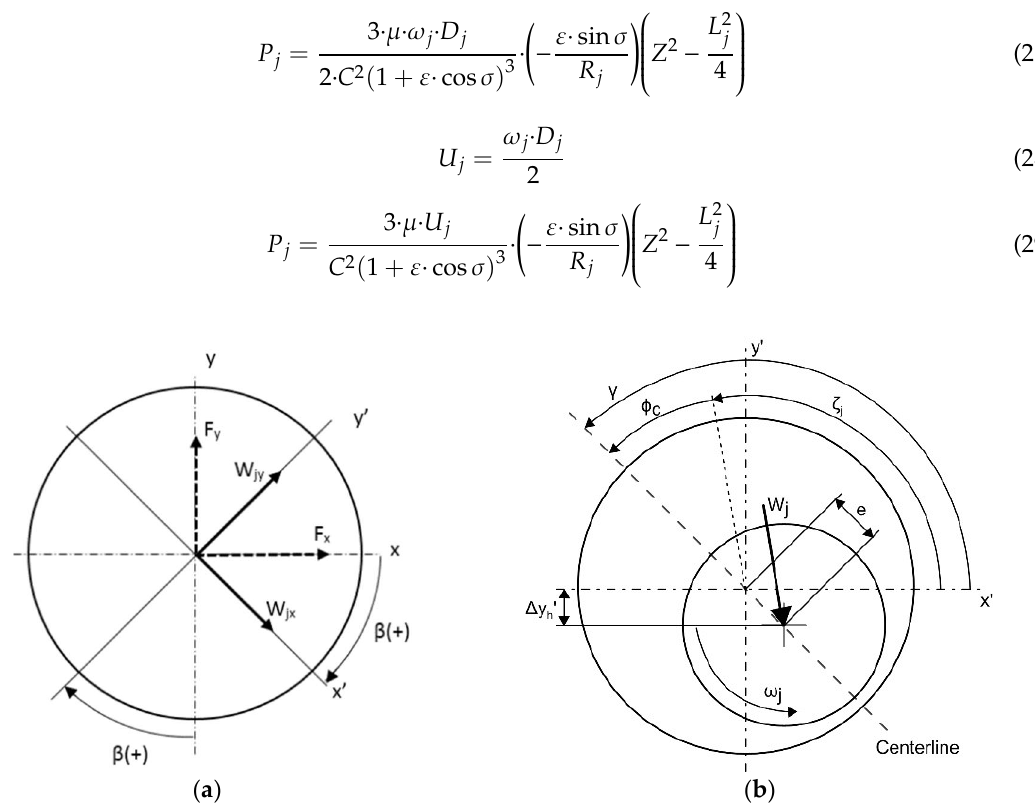
Figure6. Graphicrepresentationofthejournalbearingparameters: ( a )coordinatesystemtransformation angles and ( b ) resultant load and centerline Figure 6. Graphic representation of the journal bearing parameters: ( a ) coordinate system transformation angles and ( b ) resultant load and centerline orientation.